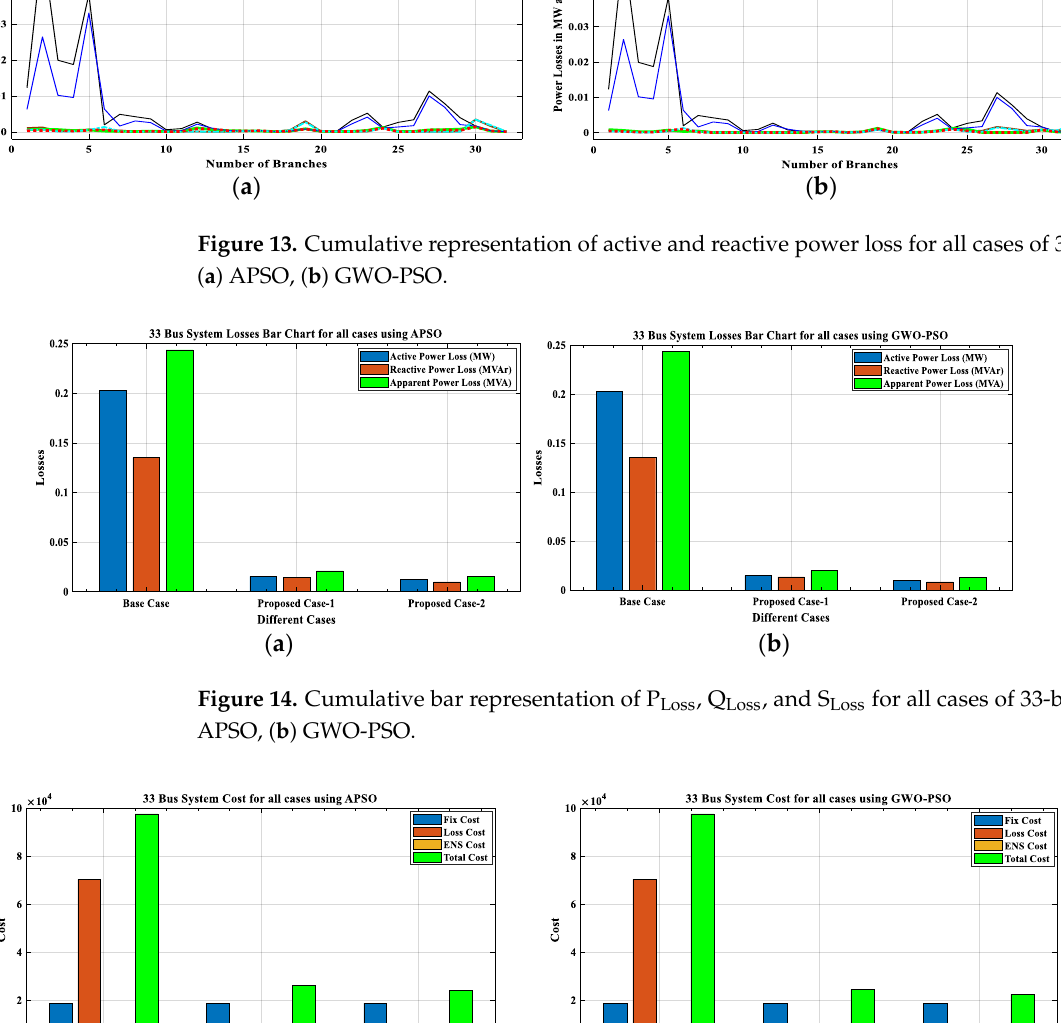
( a ) ( b ) Figure 16. Reliability indices with system reliability of the 33-bus RDN; ( a ) APSO, ( b ) GWO-PSO. ( a ) ( b ) Figure 17. Proposed cases 𝑀𝑂 𝐹𝐹 of the 33-bus RDN; ( a ) APSO, ( b ) GWO-PSO. ( a ) ( b ) Figure 18. All proposed cases ’ percentage reliability of the 33-bus RDN; ( a ) APSO, ( b ) GWO-PSO. From the comparative analysis between APSO and GWO-PSO, it can be concluded that the outcomes of GWO-PSO are superior to the APSO. Finally, the detailed analysis of the results indicates that the concurrent optimal planning of multi-Renewable Solar-DG